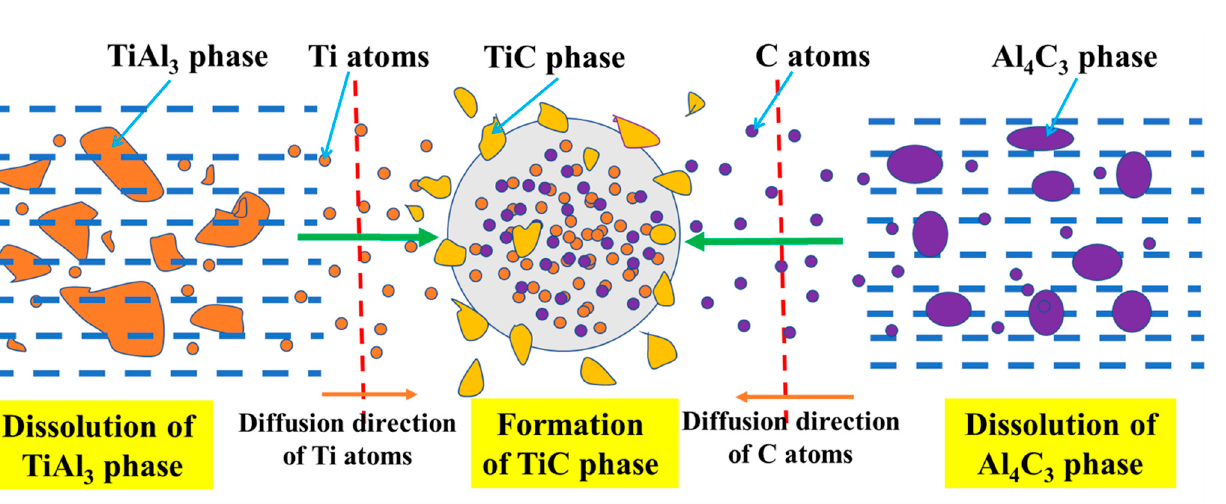
Figure 8. Schematic illustration of the formation of TiC from the reaction of Al 4 C 3 and TiAl 3 .